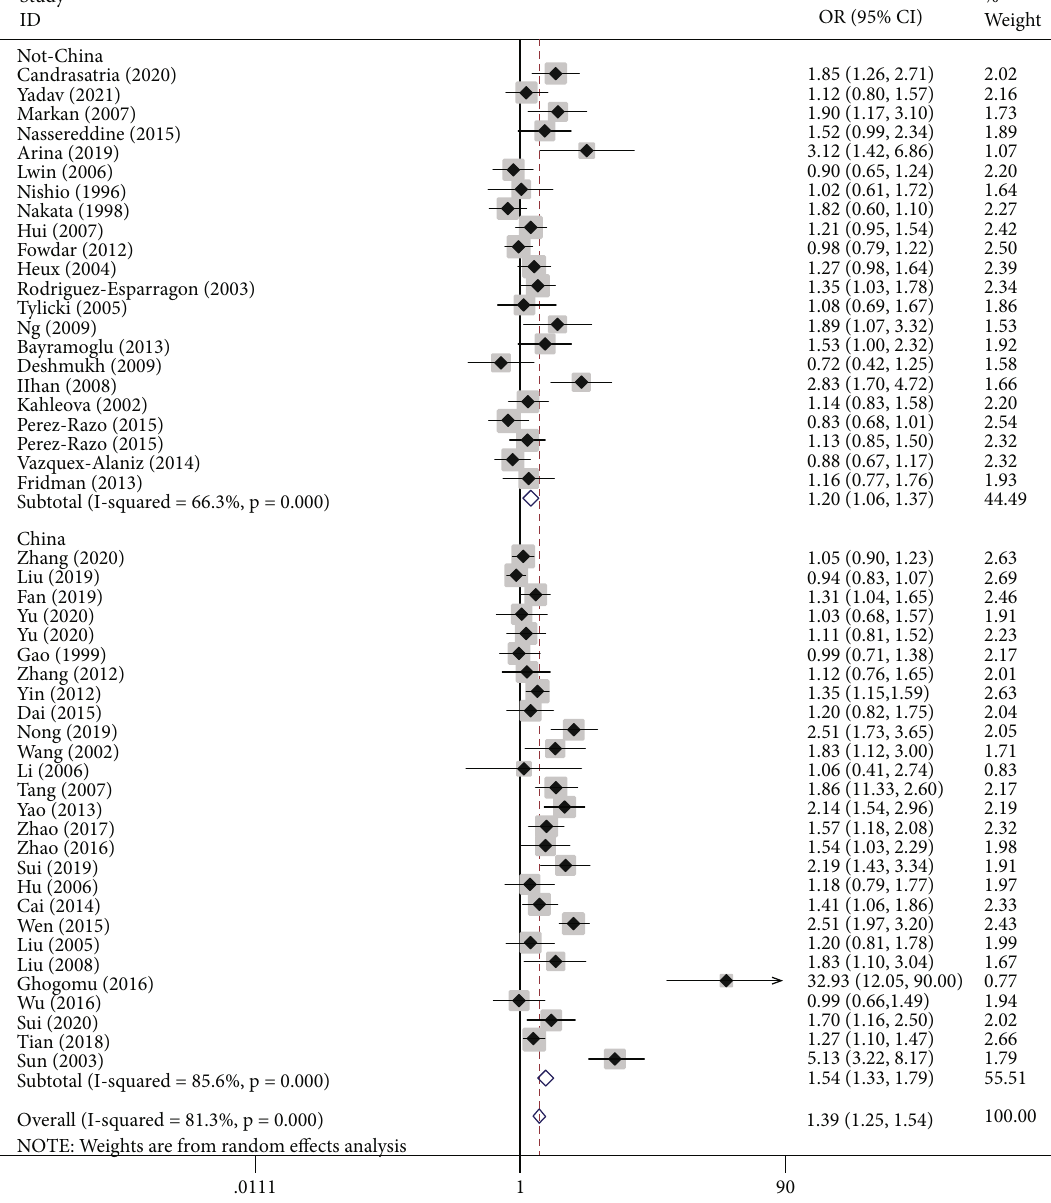
Figure 5: T-allele frequencies for the MTHFR gene rs1801133 polymorphism among cases/controls strati fi ed by subgroups in T-allele vs. C- allele model in Chinese/non-Chinese